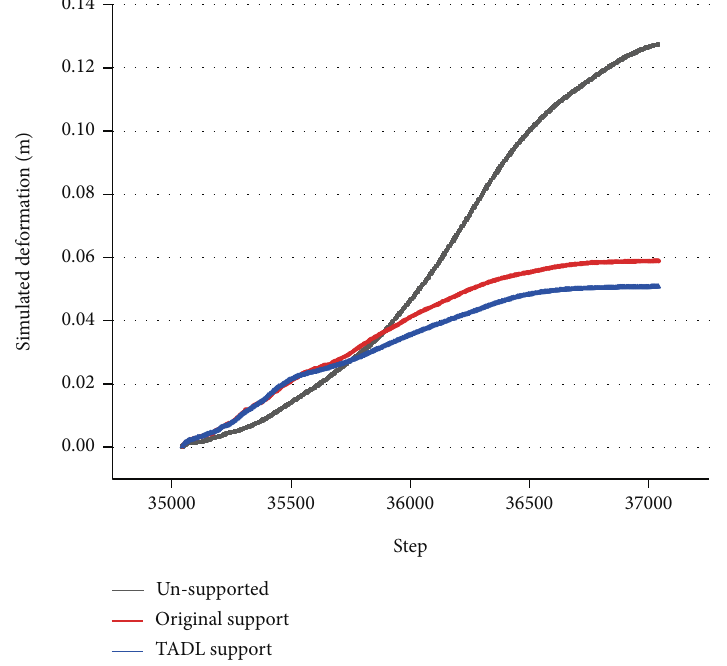
Figure 12: Simulated deformation curves of roadway under three support schemes. 0020.